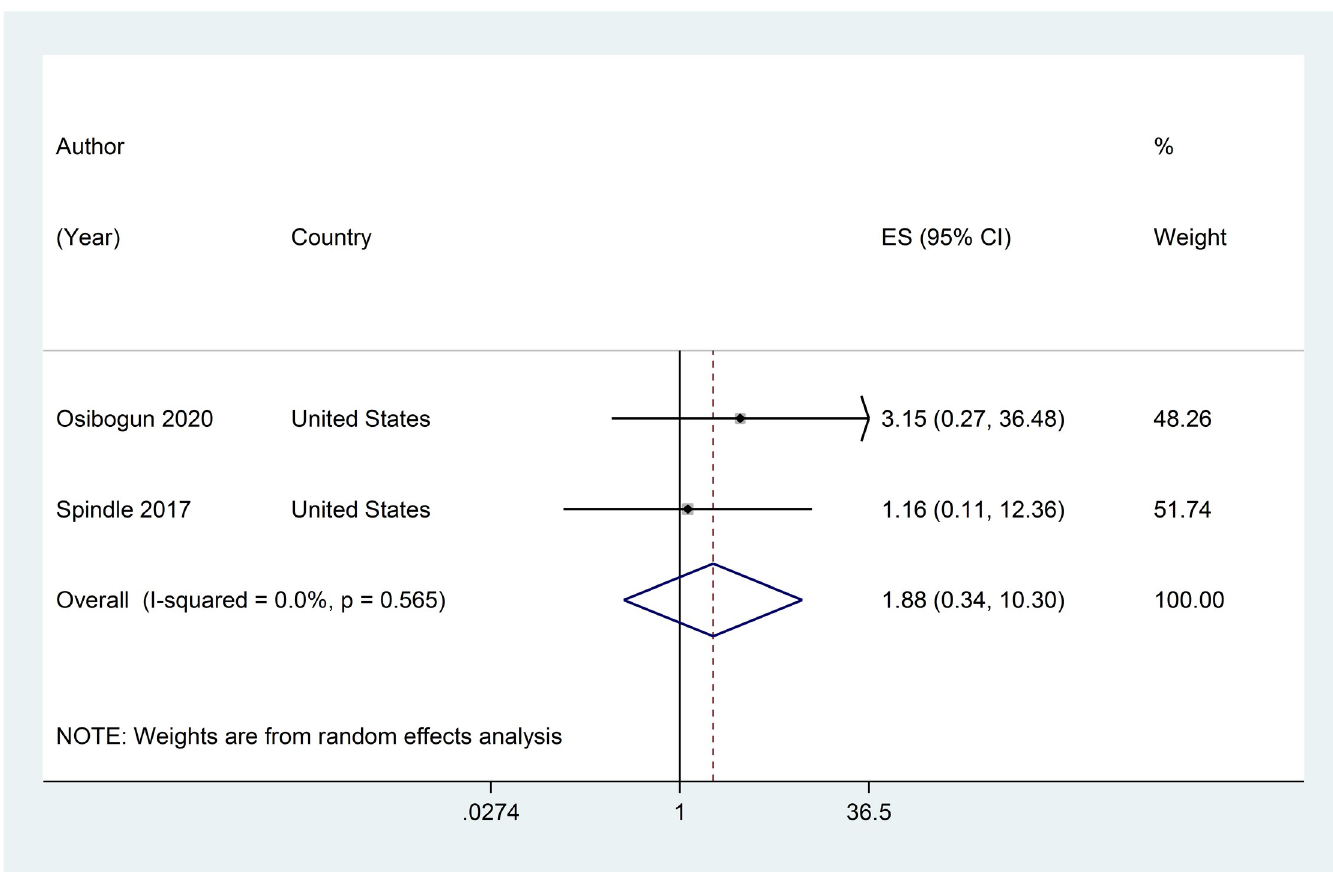
Fig 6. Forest plot of adjusted risk ratios assessing the association between current e-cigarette use at baseline and subsequent current cigarette use at follow-up.